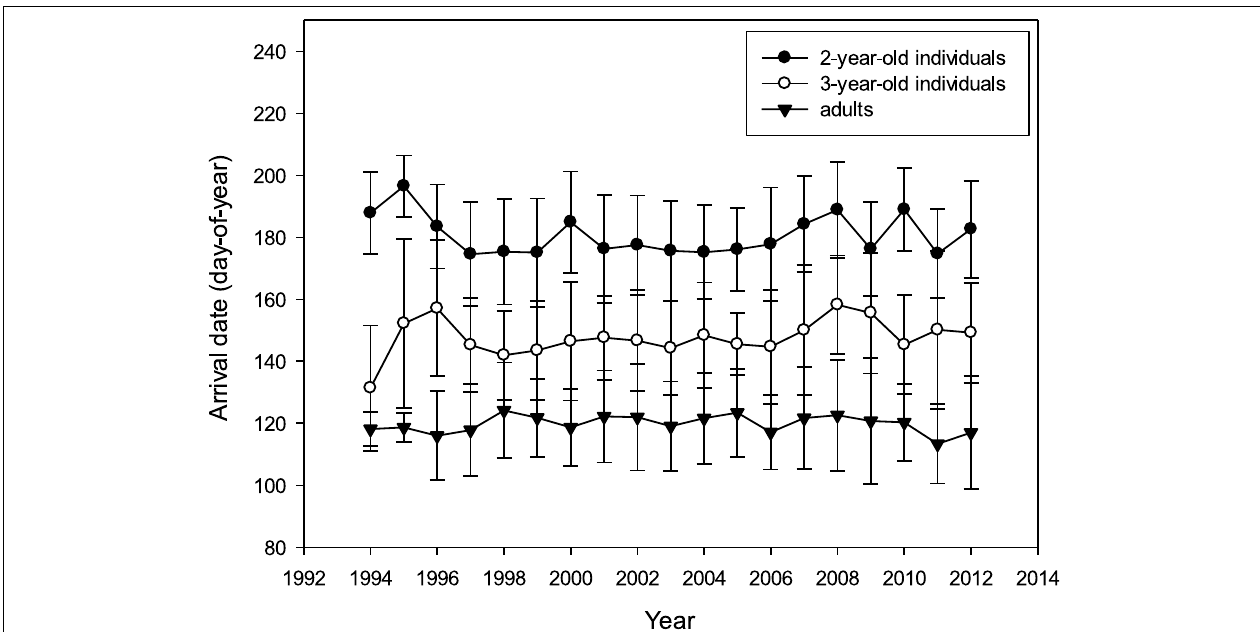
FIGURE 2 | Arrival date (day-of-year: mean ± SD; raw data) at the colony for 2-year-olds, 3-year-olds and adults between 1994 and 2012 (N 2y = 1433 , N 3y = 1139 , N ad = 5279